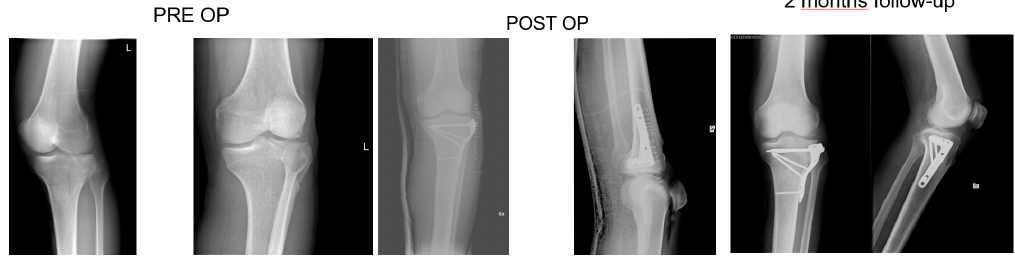
Figure 3. 68 years old patient, X-rays: preoperative, postoperative and control at 2 months follow up of a Shatzker type 2 fracture, AO 41 B1.3.